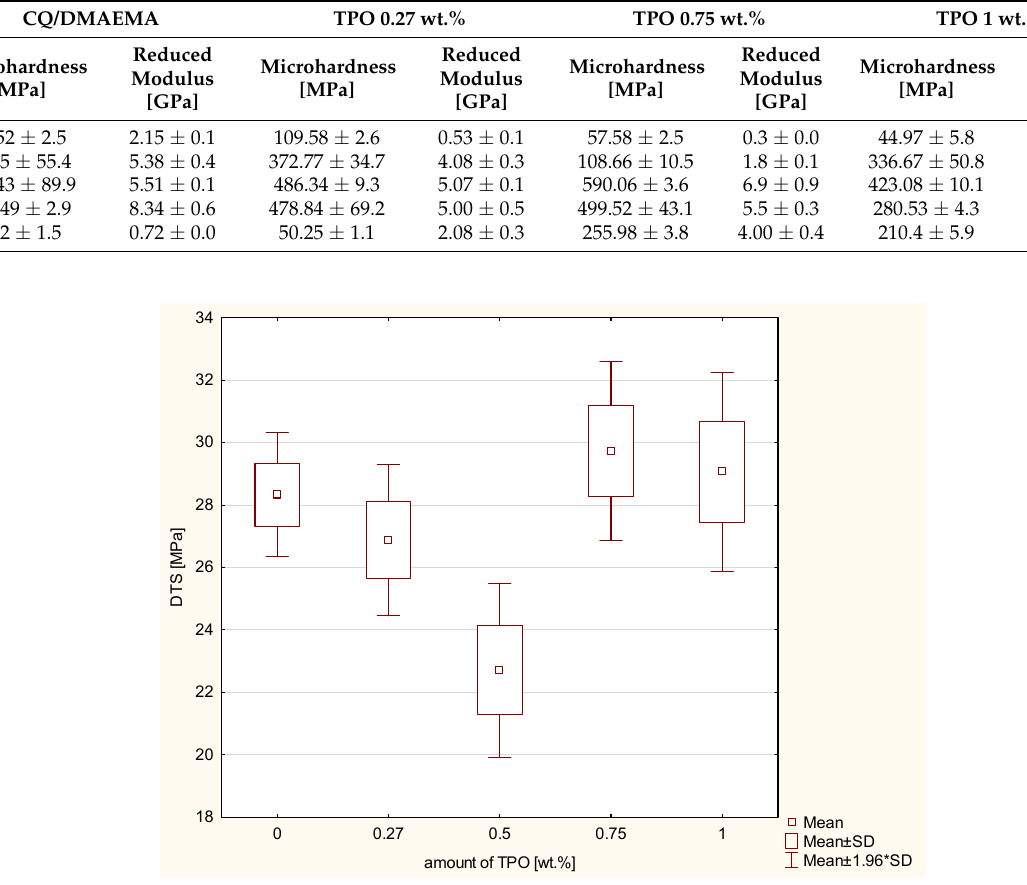
Figure 2. Box-and-whisker plot of diametral tensile strength (DTS) [MPa] of experimental composites including different concentration of TPO and values of control group–CQ and DMAEMA; photopolymerization both side of samples 20 s per 2 mm thickness of composites with Valo lamp light intensity 1450 mW/cm 2 .